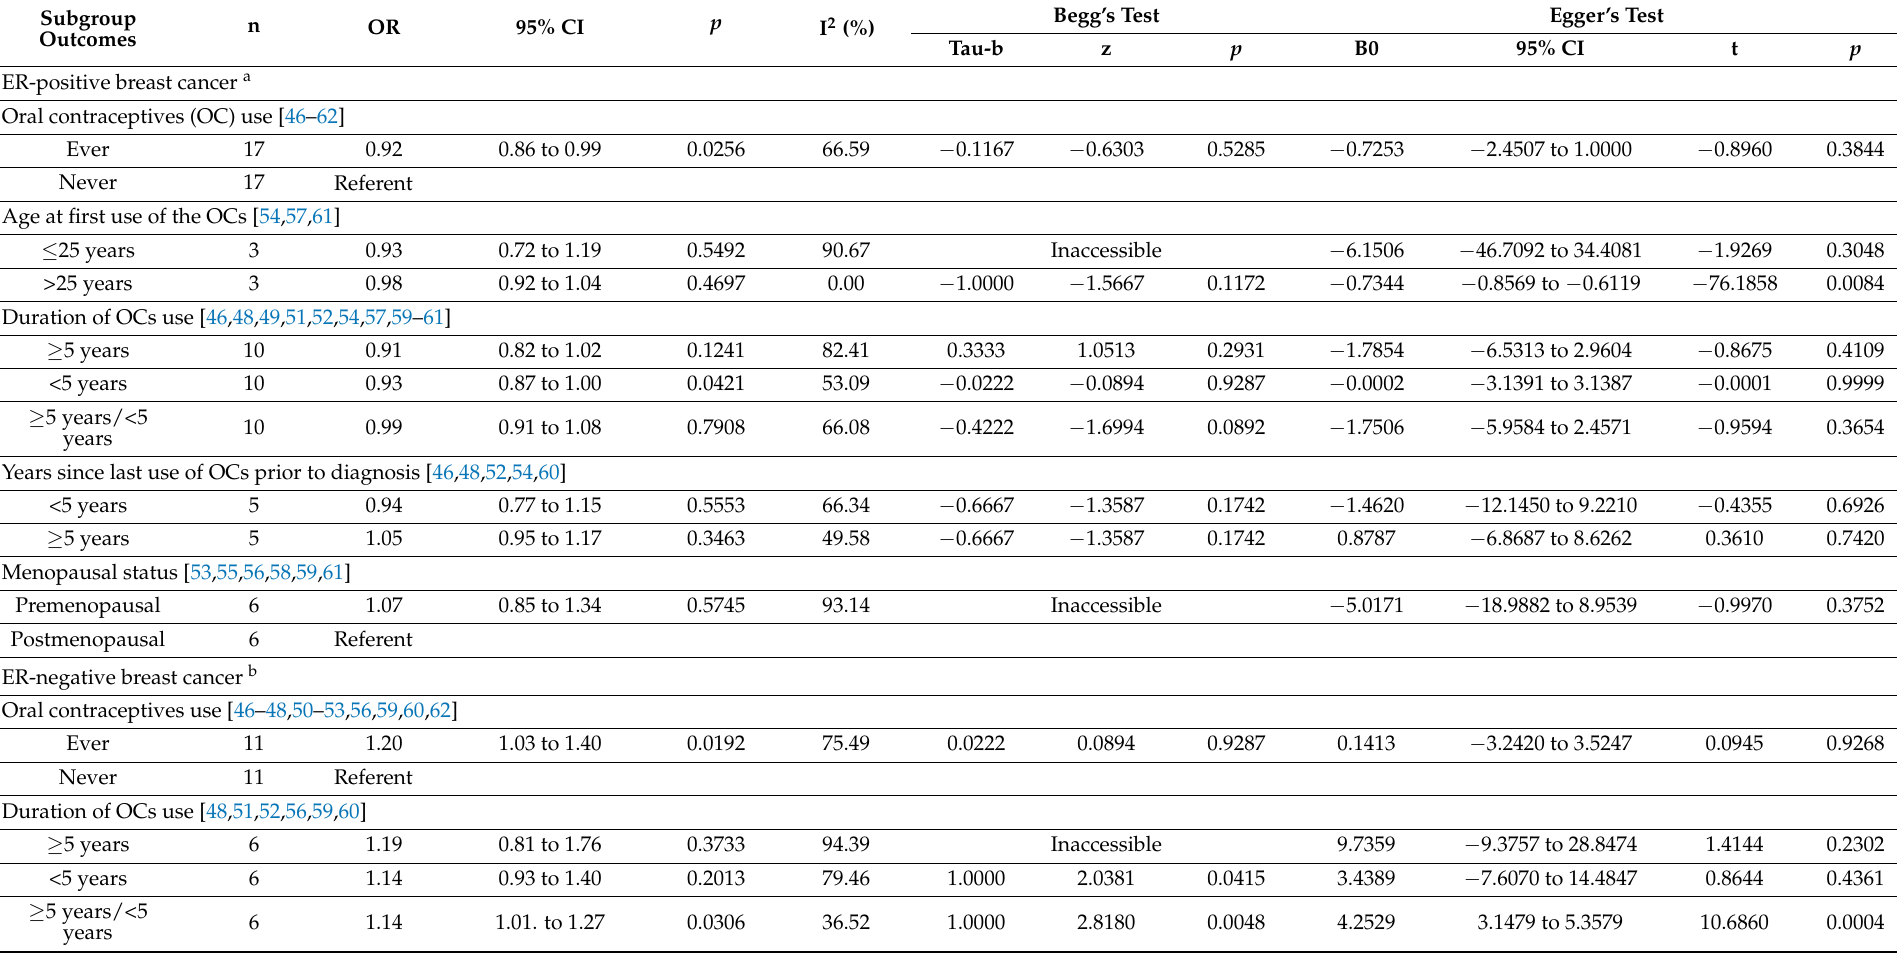
Table 2. Pooled estimates of effect taking of oral contraceptives on subgroups breast cancer